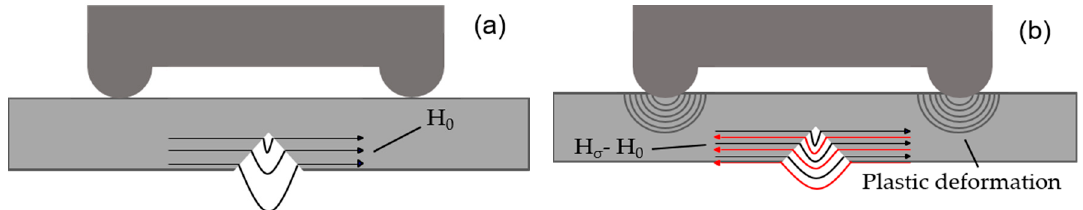
Figure 17. Magnetic field distribution of the notch: ( a ) before loading; and ( b ) after loading.